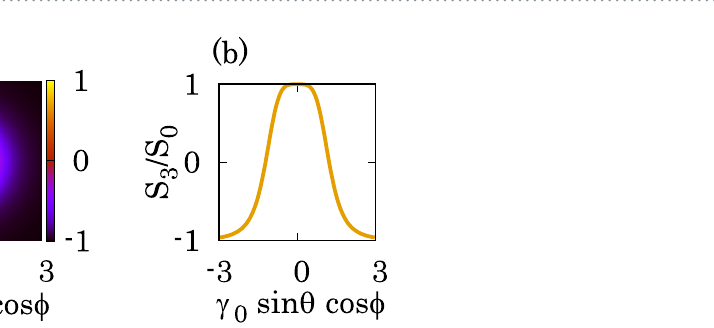
Figure 2. Calculated spatial distribution of gamma rays generated by NITS with a circularly polarized laser. Spatial intensity distributions of the ( a ) first, ( b ) second, and ( c ) third harmonics, calculated by Eq. (35) and normalized by the maximum value of the first harmonic. ( d ) Line intensity distribution along the x-axis for each harmonic number. The lines indicate the following: long dashed line, n = 1; short dashed line, n = 2; and solid line, n = 3. The other parameters are γ 0 = 2000, λ 0 = 1.0 μ m, a 0 = 1.0, and N 0 = 500. An annular shape and zero intensity at the z-axis appear only for the higher harmonics. These features are consistent with the characteristics of vortex beams.